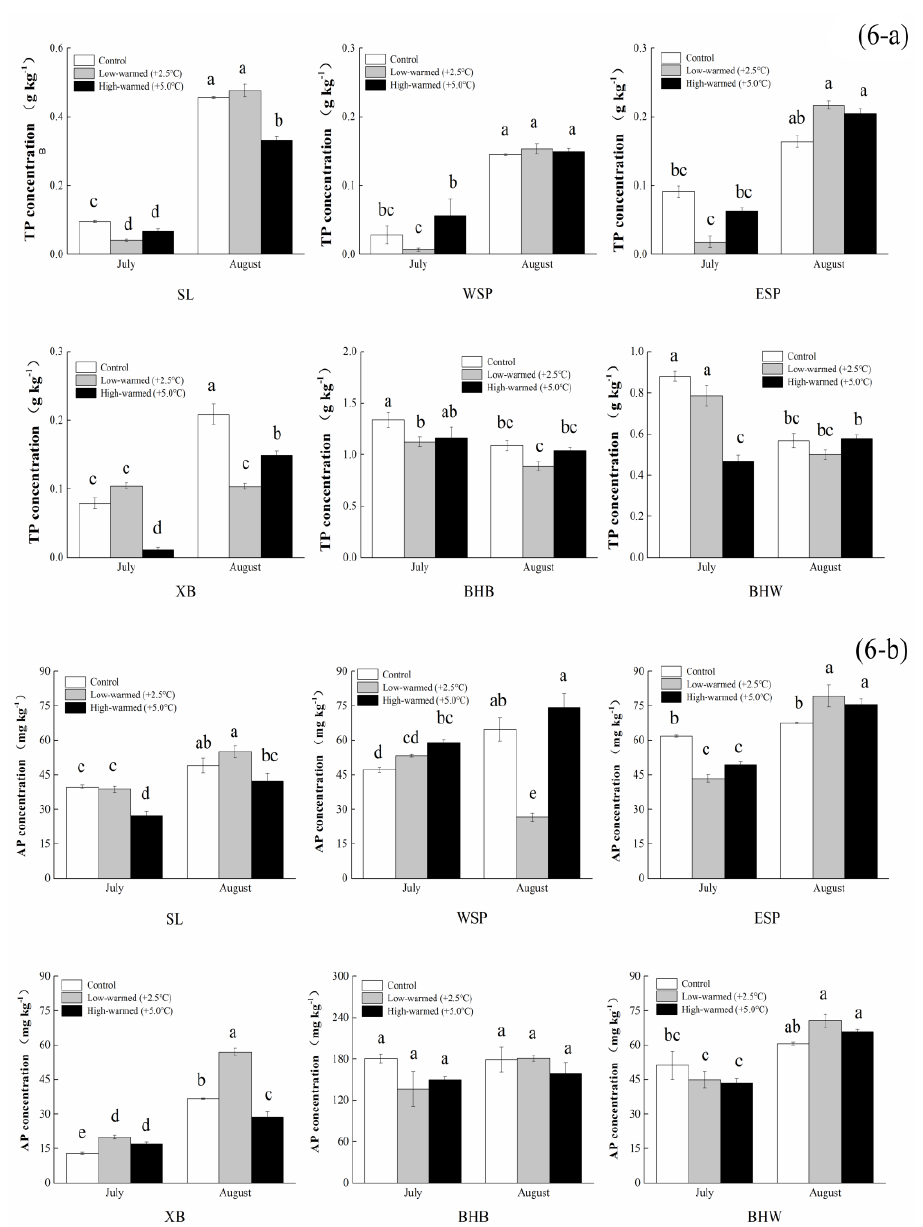
Figure 6. Statistical differences of Total Phosphorus (6- a ) and Available Phosphorus (6- b ) in sediments collected from wetland pillars in the temperature simulation experiment (control: ambient temperature; low-warmed: ambient temperature +2.5 °C; high-warmed: ambient temperature +5.0 °C). The abbreviation of wetland sampling sites is identified on the x -axis, and the TP and AP concentrations in the sediments are identified on the y -axis. Error bars represent the standard error of the mean of three parallel samples. Means with the same small letters (a, b, c, d, e) are not significantly different at p = 0.05.